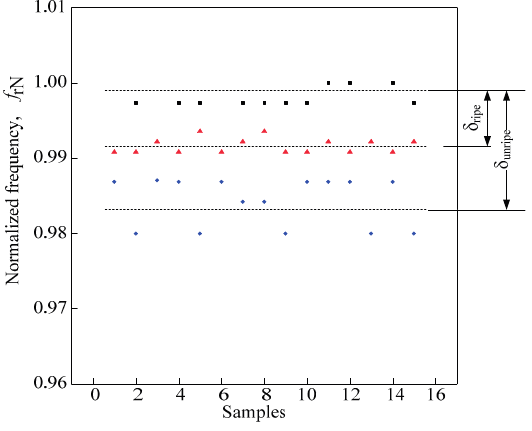
Table 7. Standard deviation and variance for ripe and unripe vs. air.